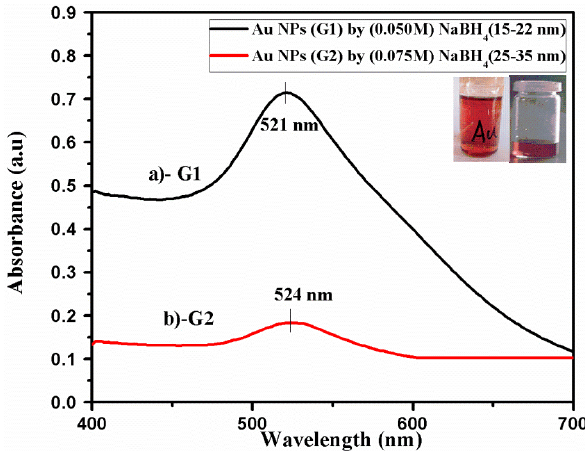
Figure 1. Ultra violet (UV)-visible spectrum of gold nanoparticles synthesized by the reduction of ( a ) 0.05 M NaBH 4 (G1), ( b ) 0.075 M NaBH 4 (G2) used as prepared.